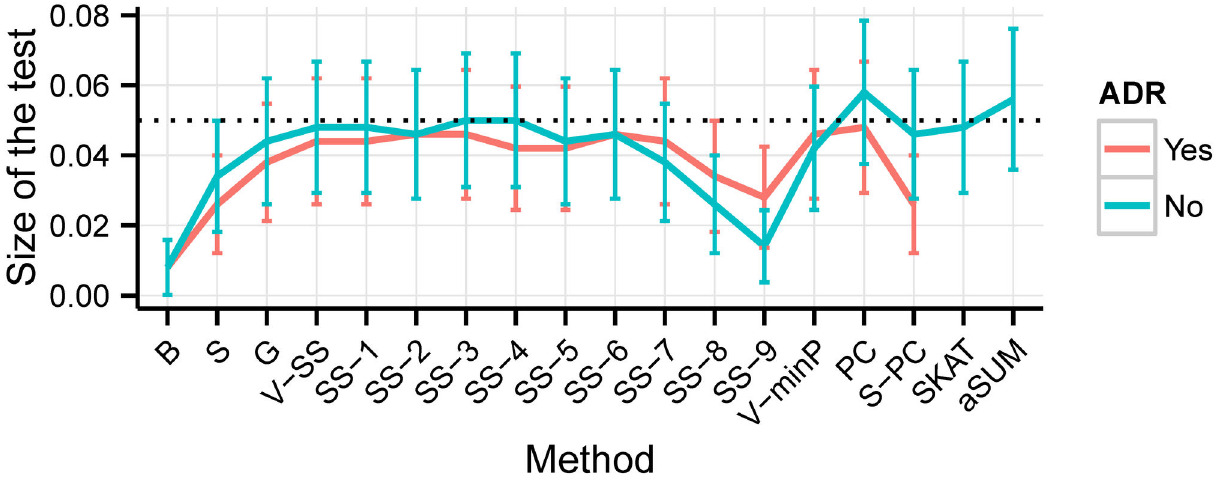
Figure 1. Empirical size of the test under Experiment II as a function of the method type and the ADR adjustment status. The nominal type I error rate is α =0.05. The bars represent the 95% confidence interval for the size of test. Abbreviations for methods are as follows: B - Bonferroni, S - Simes, G - GATES, V-SS - VEGAS-SS, SS-x - SS-T with x =1,...,9, V-minP - VEGAS- minP, PC - principal component method, S-PC - Simes adjustment of Simes and PC methods, SKAT - sequence kernel association test, aSUM - data-adaptive sum